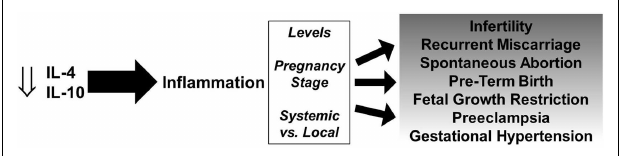
FIGURE 1 | Role of IL-4 and IL-10 in pregnancy disorders . Decreased levels of IL-4 and IL-10 promote persistent inflammation and depending on the levels, stage of pregnancy, and systemic vs. local effects, can lead to a spectrum of gestational complications.